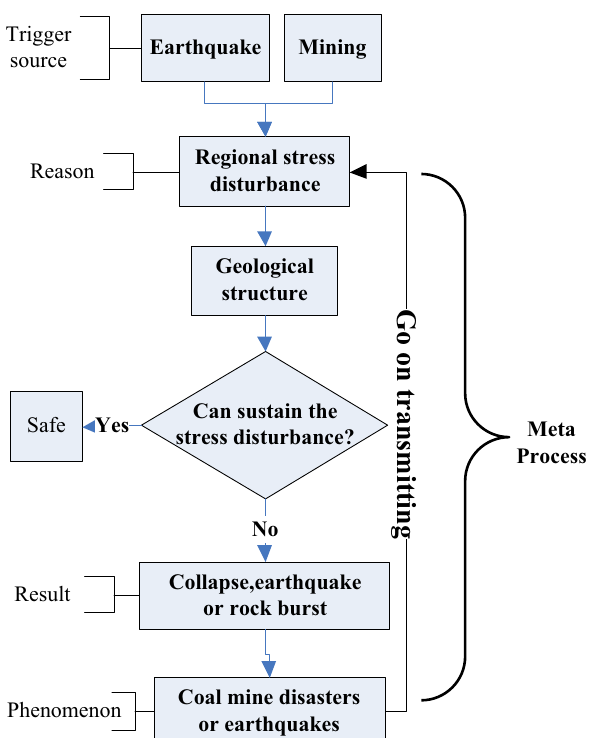
Fig. 14 Flow chart of the meta-process of stress disturbance bringing about coal mine disasters